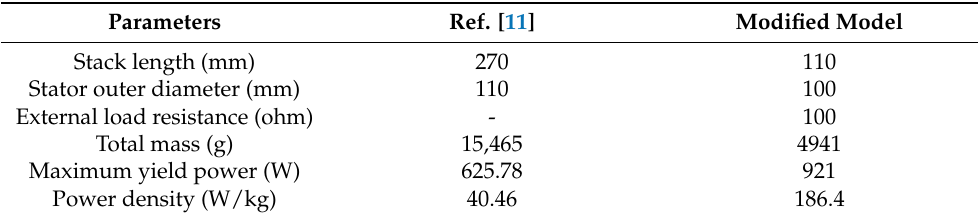
Table 6. Comparison of dimensional and performance parameters of Ref. [11] model and the modified